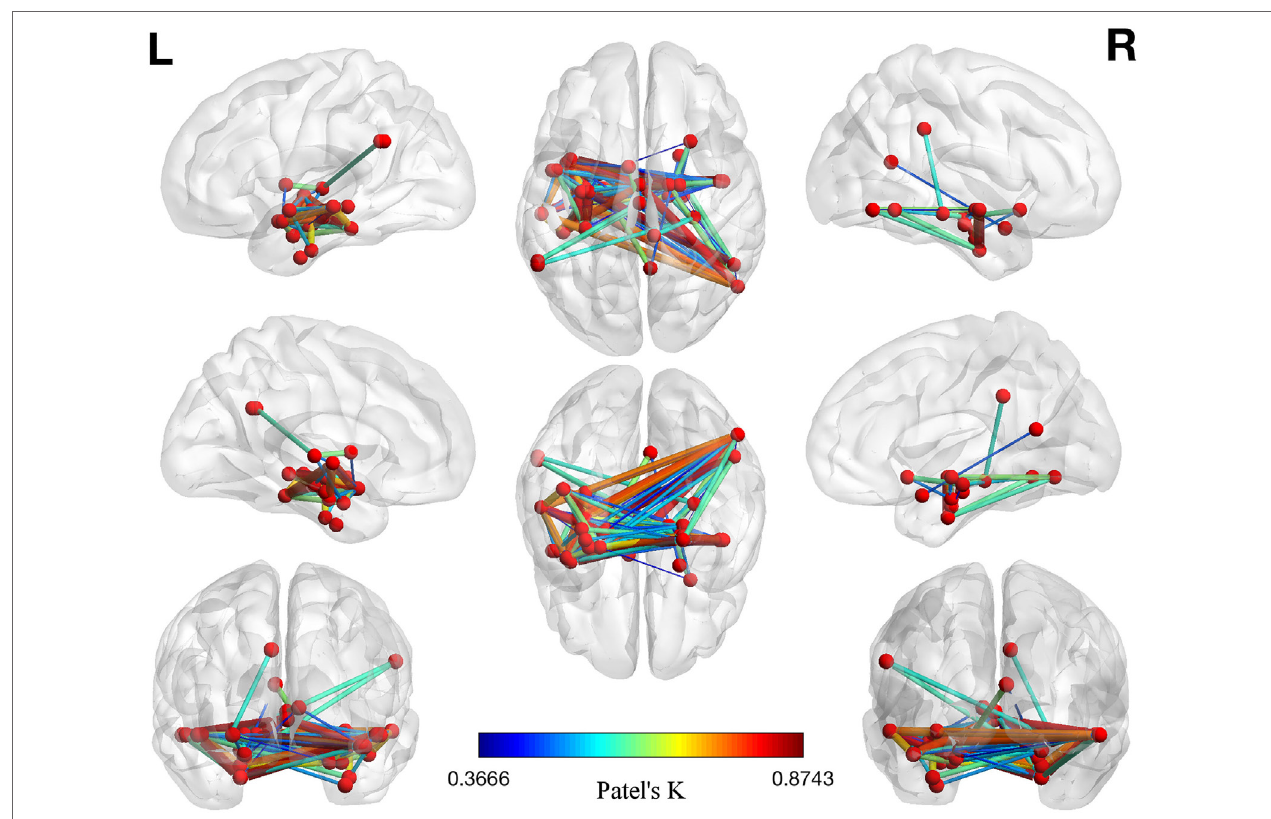
FigUre 3 | Morphometric coatrophy network results. Colors from blue to red indicate increasing Patel’s k values (i.e., increasing coalteration